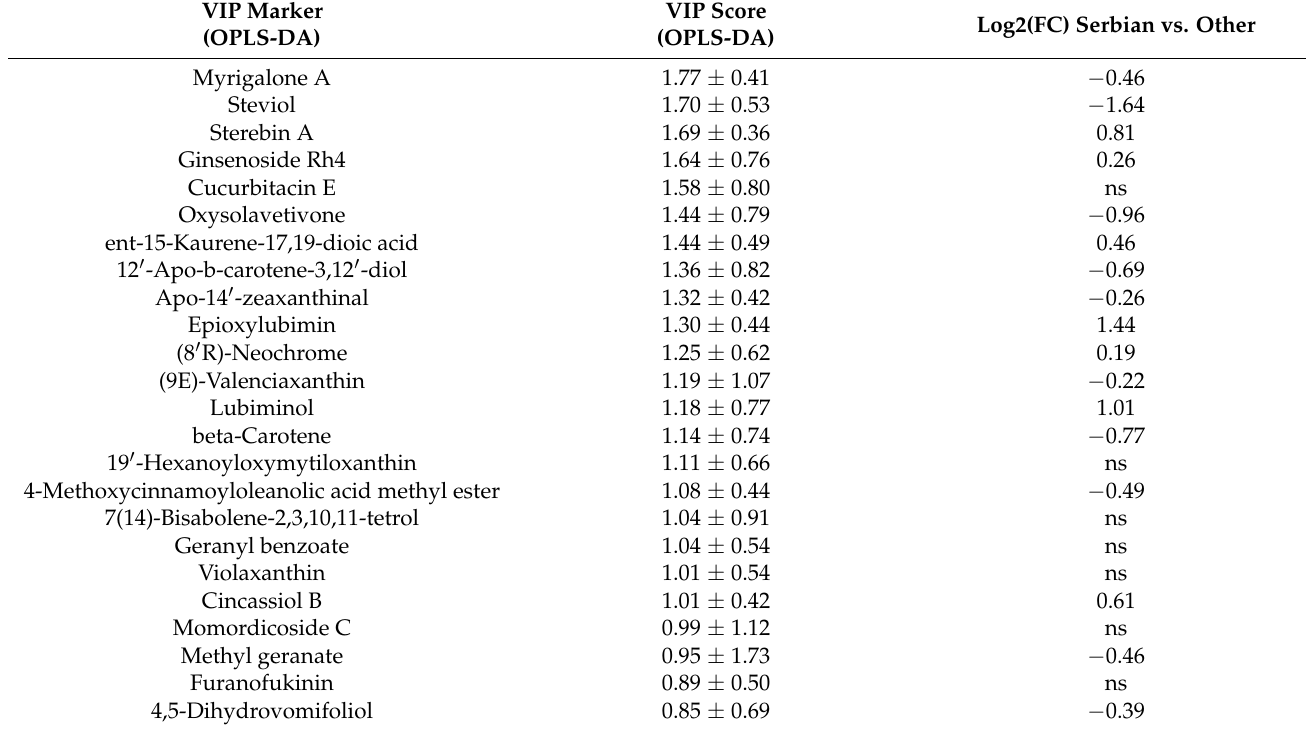
Table 1. Discriminant terpenoids according to the comparison between pumpkins originating from Serbia and those originating outside Serbia. Compounds were identified by the VIP (variable importance in projection) approach following OPLS-DA discriminant analysis. The VIP scores (a measure of variable’s importance in the OPLS-DA model) and the corresponding cv SE (cross-validated standard errors) together with the Log2 fold-change values (FC > 1.1, p < 0.05) for the comparison “Serbian” vs. “Other” pumpkins are also provided. ns = not significant.